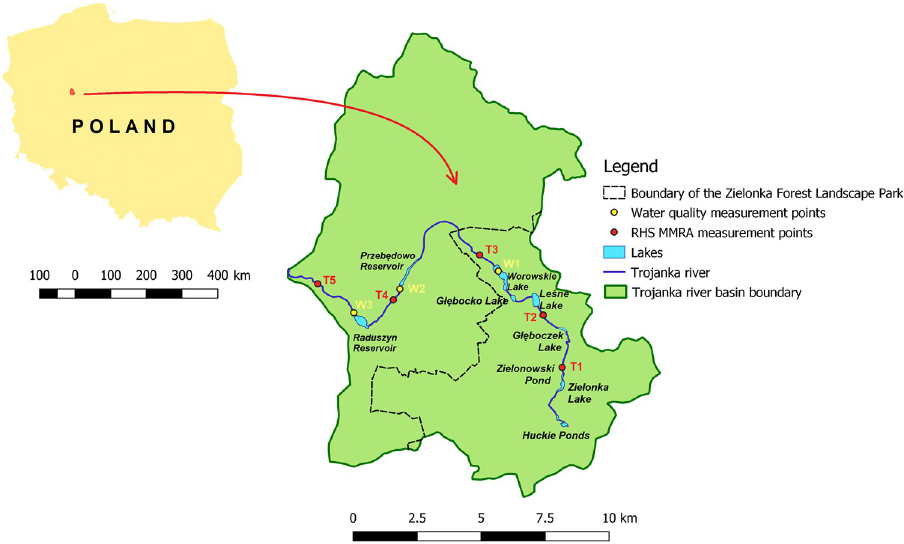
Fig 1. Trojanka River catchment area (shapefile source: https://dane.gov.pl/).